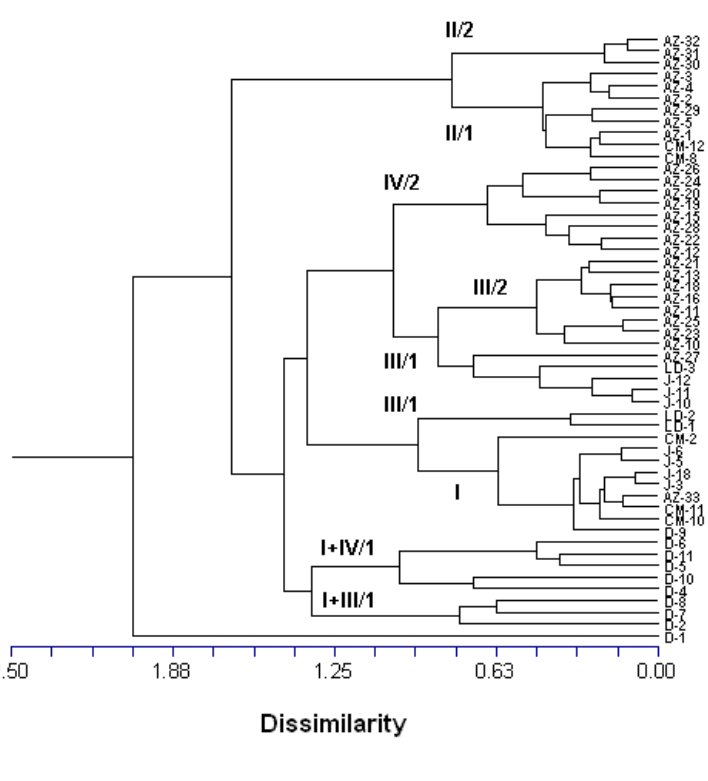
Fig. 4 Average group dendrogram of the coal samples using the Euclidean